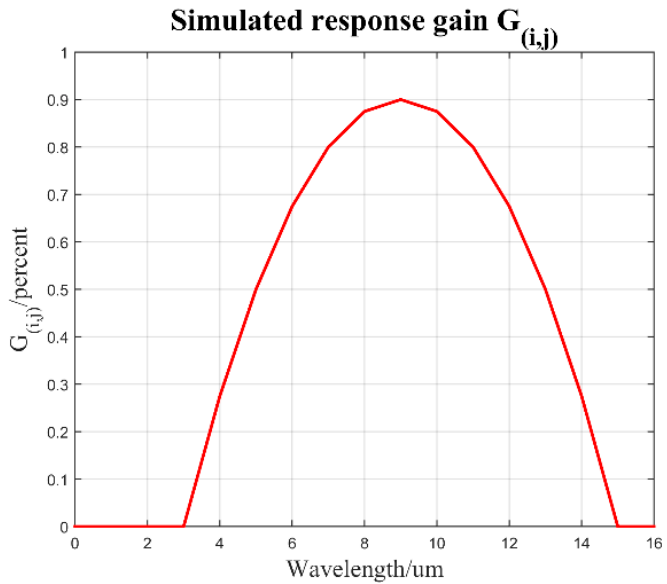
Figure 3. The simulated response gain G i,j .